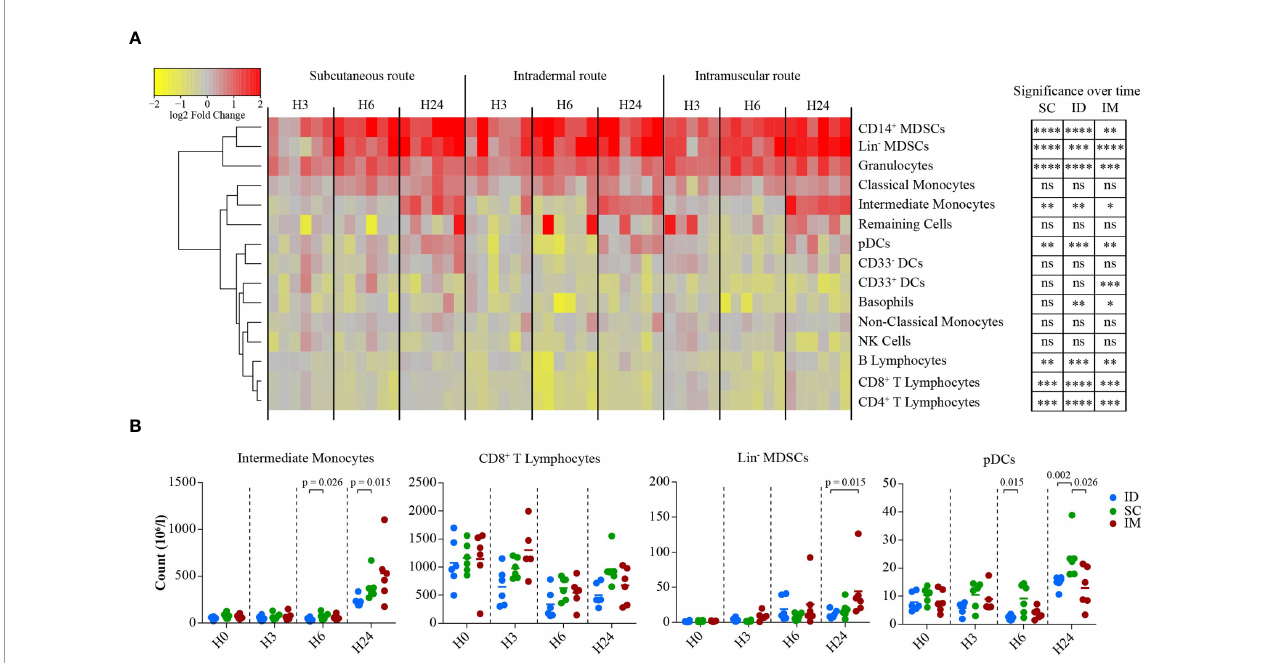
FIGURE 4 | Impact of the SC/ID/IM routes on early systemic immunity. (A) Heatmap representation showing the changes in cell abundance (in log2 fold change) of populations characterized by fl ow cytometry in the blood 3, 6, and 24 h after SC/ID/IM MVA injection. Populations were organized based on their cell abundance by hierarchical clustering and are represented by a dendrogram. Changes in cell abundance of each population were normalized and are represented by a color-gradient scale ranging from yellow to red. Signi fi cant changes over time are indicated on the right (B) Scatter plot showing the kinetics of changes in cell abundance for selected cell populations. Each dot represents one single biological sample. ns, non-signi fi cant; *0.05 > p > 0.01; **0.01 > p > 0.001; ***0.001 > p > 0.0001; ****p <